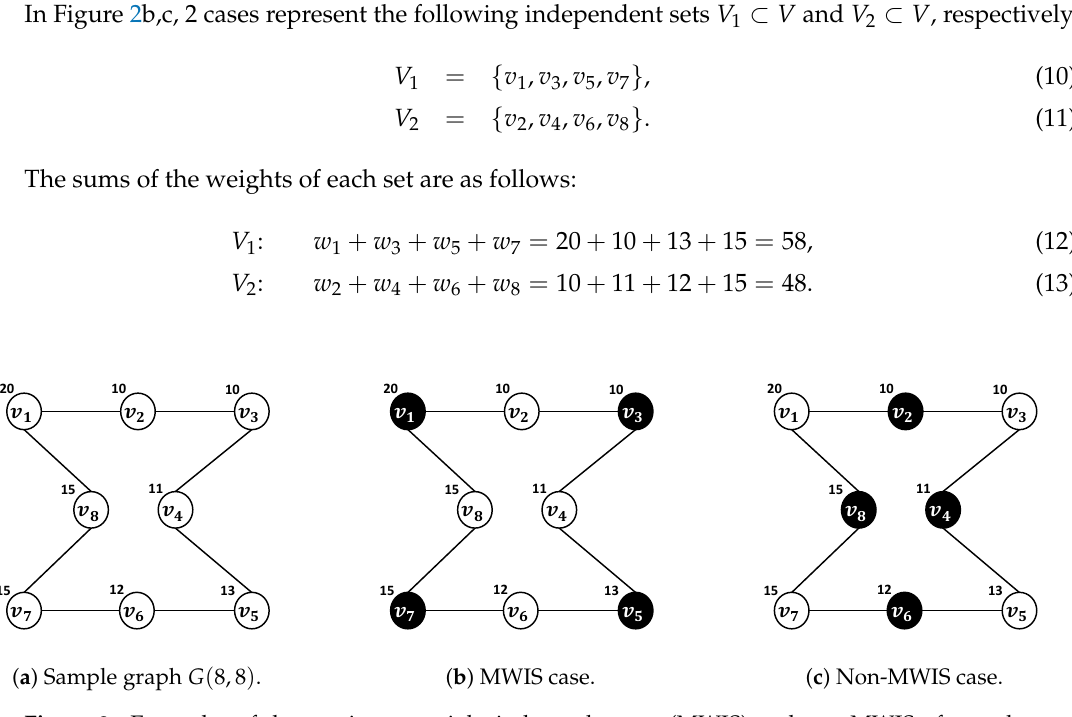
Figure 2. Examples of the maximum weight independent set (MWIS) and non-MWIS of sample graph G ( 8,8 )